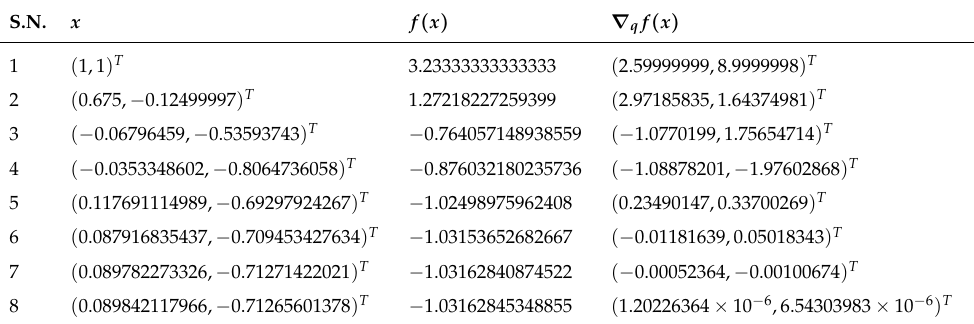
Table 2. Numerical results for Modified q -BFGS algorithm.